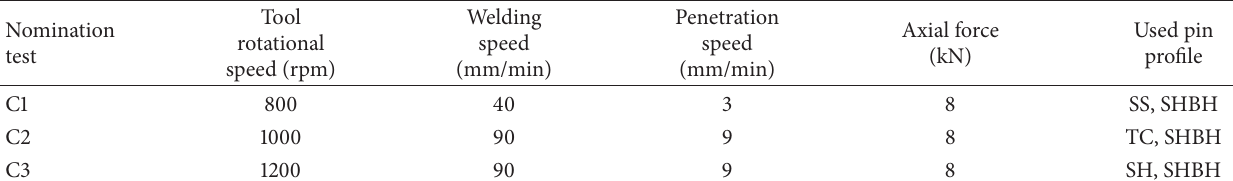
Table 3: Classification of FSW tests, according to the welding parameters.